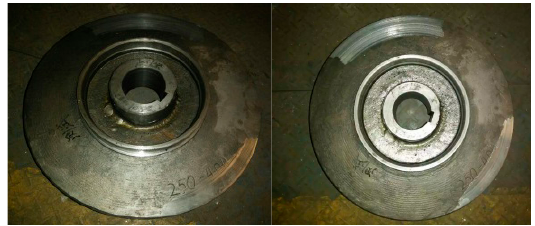
Figure 22. The casted impeller.